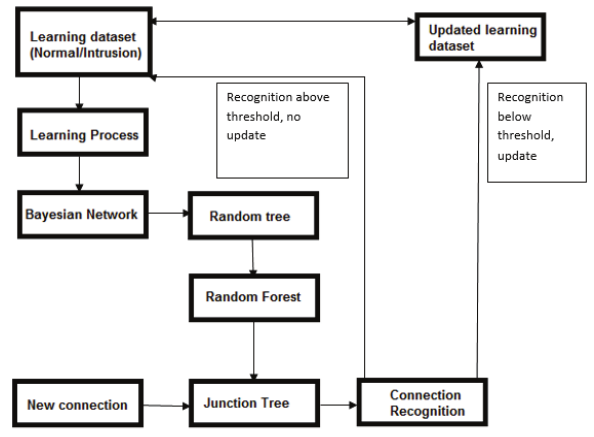
Fig. 6. System Design Classes and their relationship